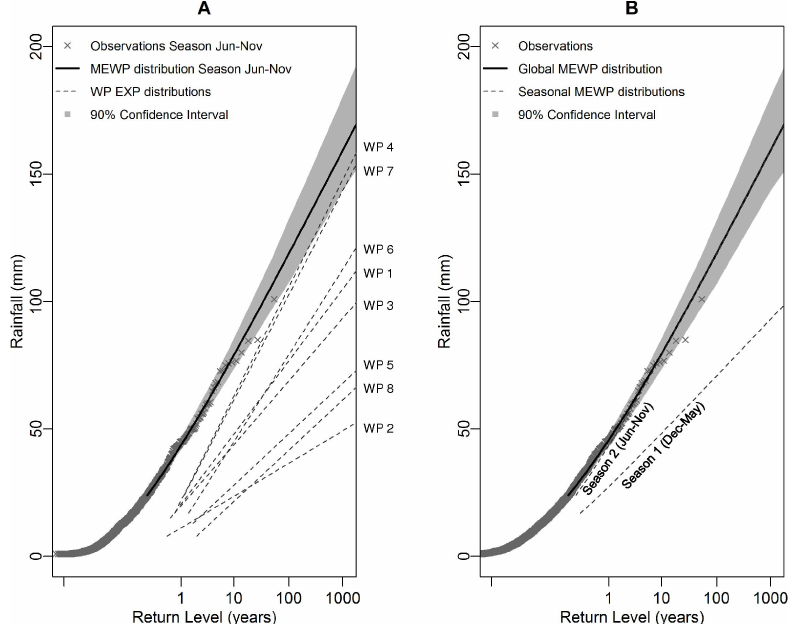
Fig. 9. MEWP distribution of the “season-at-risk” (June to November) (A) and global MEWP distribution (B) for the Lyon rain gauge (data from the period 1953–2005). The gray zone highlights the 90% confidence intervals.